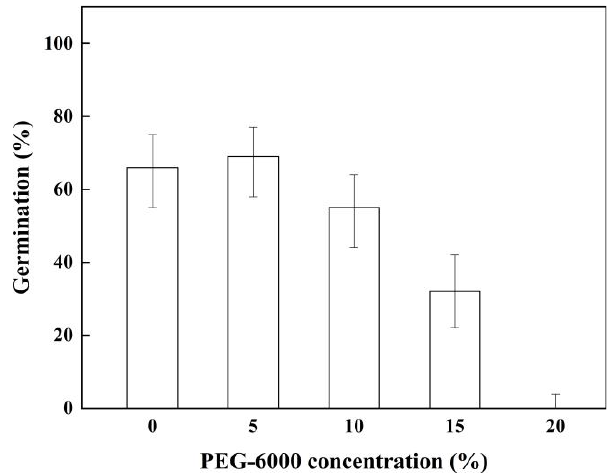
Figure 4. Germination percentage (±95% binomial confidence intervals) of P. kansuensis seeds treated with different PEG-6000 concentrations in 12 h light/12 h dark at 10/25 °C.